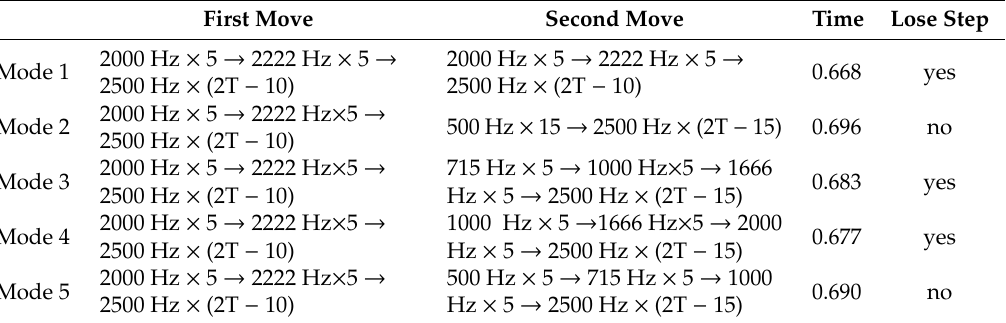
Figure 26. Time distribution diagram 2 of pulse frequency in the second control mechanism. Table 9. Pulse mode in the first control mechanism.